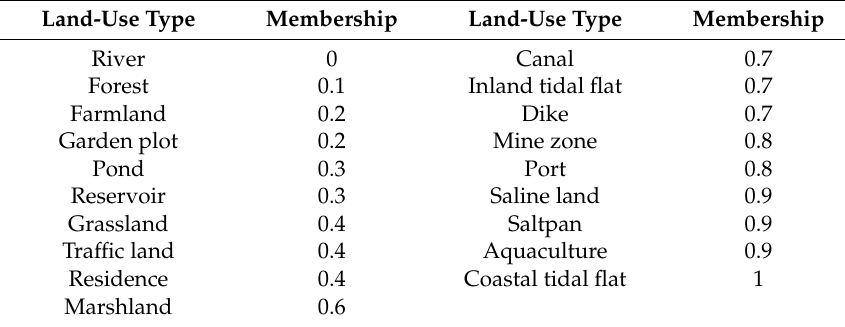
Table 3. Membership values of different land-use types.